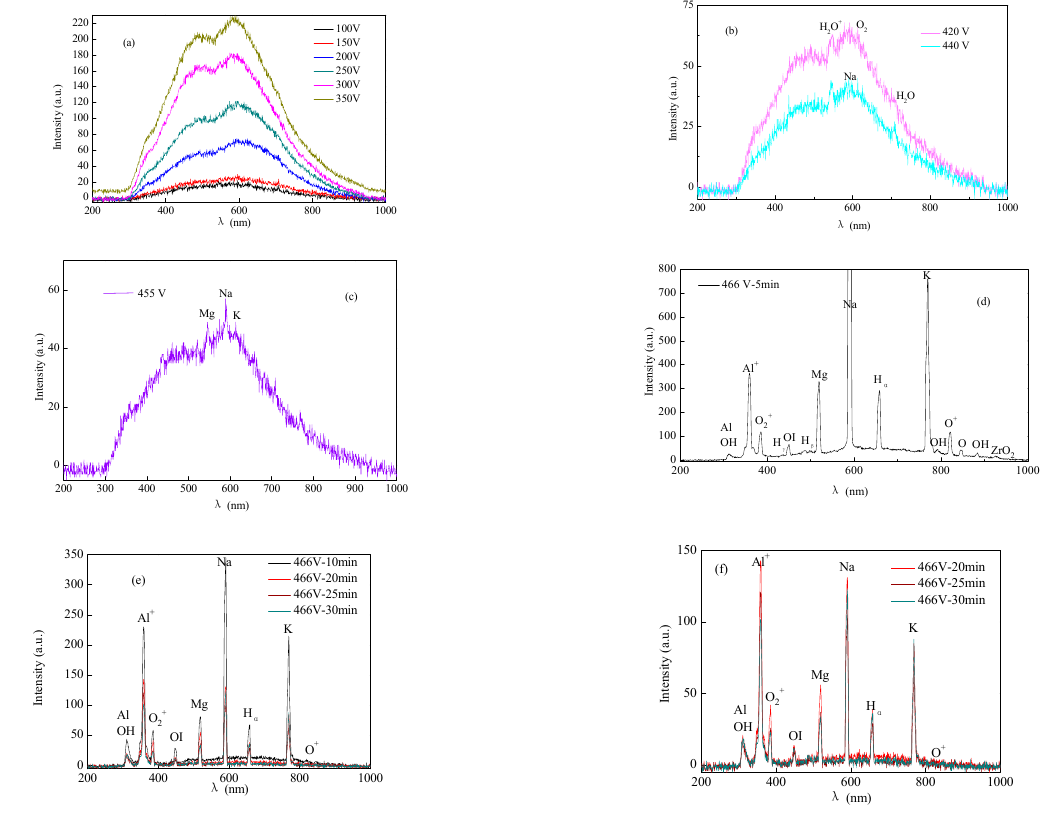
Figure 3. The light emission spectra in K 2 ZrF 6 /NaH 2 PO 4 electrolytes during the PEO process at different voltage and time ( a ) 100 V, 150 V, 200 V, 250 V, 300 V, 350 V; ( b ) 420 V, 440 V; ( c ) 455 V; ( d ) 466 V-5 min; ( e ) 466 V-10 min, 466 V-20 min, 466 V-25 min, 466 V-30 min; ( f ) 466 V-20 min, 466 V-25 min, 466 V-30